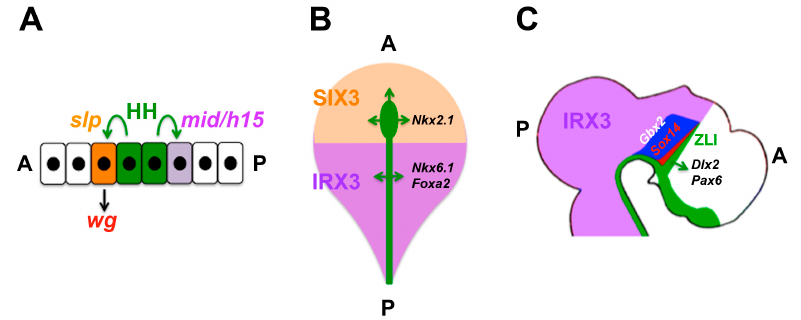
Figure 4. Three examples for domains of differential competence for HH signalling. ( A ) In the Drosophila embryo, HH (green) is released at the anterior border of each parasegment [129,130]. Anteriorly, the expression of slp (orange) endows cells with competence for the induction of wg (red); posteriorly, mid/h15 (purple) prevents wg induction by HH [131–133]. ( B ) In the anterior neural plate of the chick embryo, SIX3 (orange) endows cells with competence for the induction of Nkx1.2 by SHH (green) whereas IRX3 (purple) endows cells with competence for the induction of NKX6.1 and FOXA2 posteriorly [141]. ( C ) In the forebrain, SHH (green) induces Sox14 - and Gbx2 -positive neurons of the thalamus dose-dependently posterior to the ZLI, but Dlx2/Pax6 -positive neurons anteriorly [142]. Thalamic competence is mediated by IRX3 posterior to the ZLI [143,148]. A, anterior; P, posterior; ZLI, zona limitans intrathalamica.